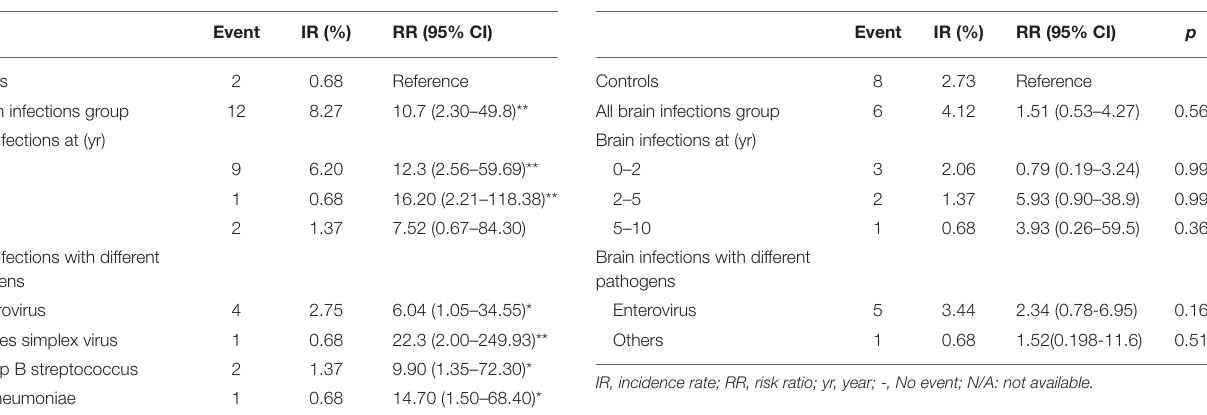
TABLE 3 | Incidence rates and relative risks of ADHD for the controls compared with brain infections